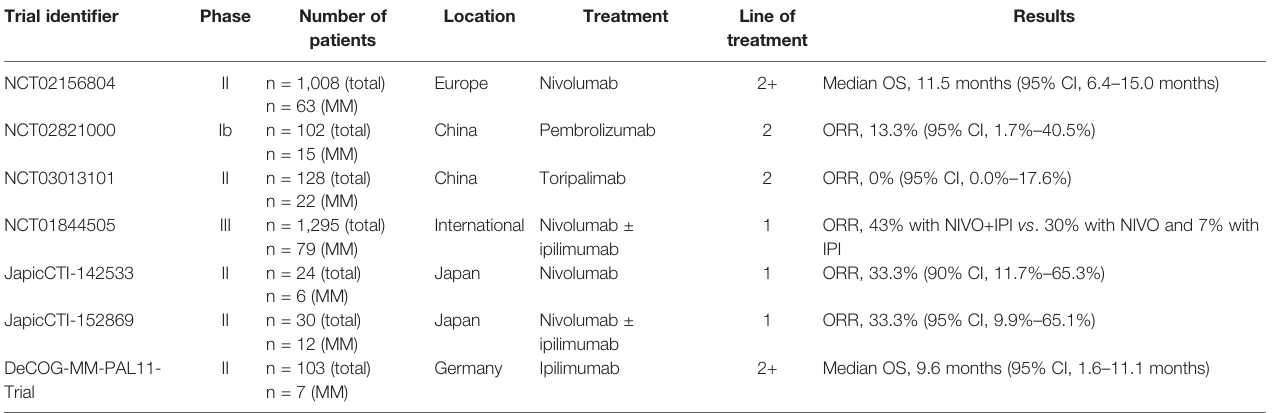
TABLE 2 | Summary of immunotherapy clinical trials involving sub-analysis of patients with mucosal melanoma. Trial identi fi